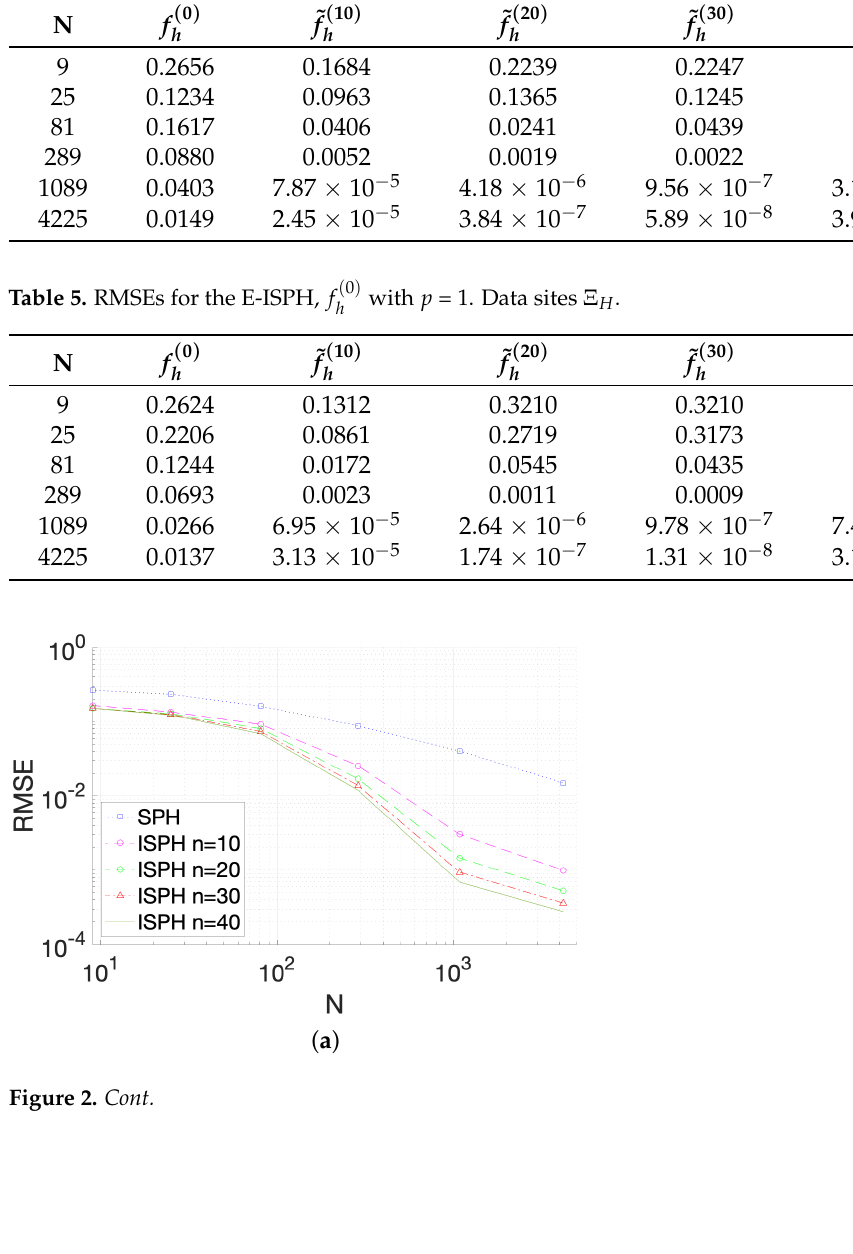
( 0 ) with p = 1. Data sites Ξ G . h